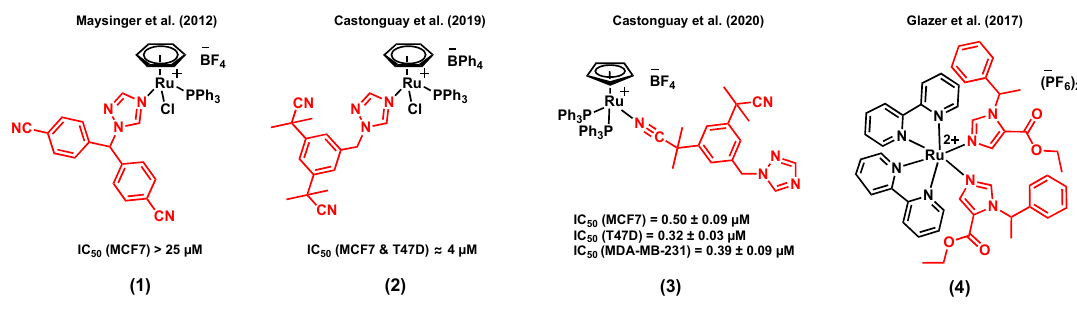
Figure 1. Ruthenium complexes bearing P450 enzyme inhibitors.